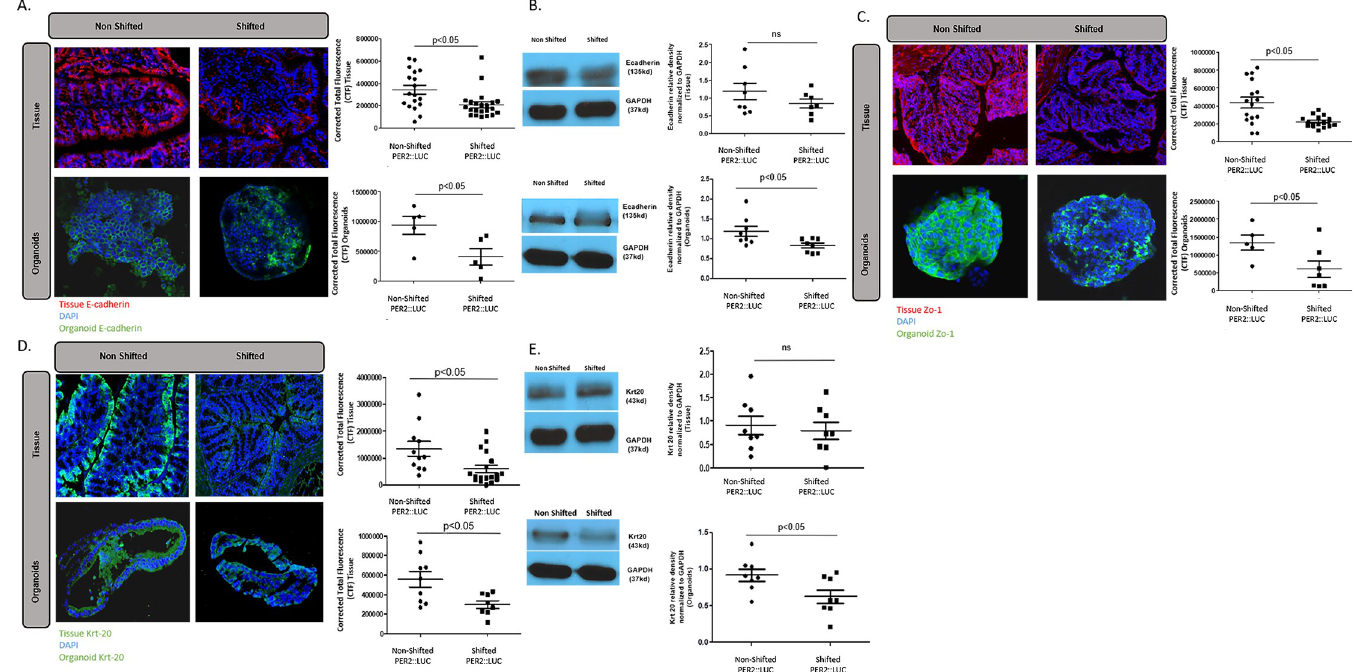
Fig 4. Colon tissue and organoid AJC protein expression is decreased with LD shifting in Per2::Luc mice. (A) Immunofluorescent staining of E-cadherin (red) in the colon tissue and organoids of shifted and non-shifted Per2::Luc mice. Both demonstrated a significant decrease in E-cadherin in the shifted mice (p < 0.05). (B) Western blot protein quantification demonstrated a similar trend in E cadherin levels. While the difference was non-significant in the tissue, the protein levels of E-cadherin were significantly lower in the colon organoids of the shifted Per2::Luc mice. (C) Immunofluorescent staining of ZO-1 (green) in the colon tissue and organoids of the shifted and non-shifted Per2::LUC mice. In both organoids and tissue, the shifted mice again demonstrated a lower amount of tight junction ZO-1 in the colons of the shifted mice (p < 0.05). (D) Immunofluorescent staining of cytoskeleton protein Krt-20 (green) in the colon tissue and organoids of shifted and non-shifted Per2::Luc mice. Both tissue and the organoids demonstrated a significant decrease in Krt-20 after shifting (p = 0.0086, 0.020). (E) Western blot protein quantification of Krt-20 levels in colon tissue and organoids of shifted and non-shifted Per2::Luc mice. No difference was seen between the non-shifted and shifted colon tissue levels of Krt-20, however, a lower amount was seen in the colon organoids of the shifted mice compared to those of the non-shifted mice (p < 0.05). This could be due to the same dilution effect seen in section B. Per2:Luc mice colon tissue and organoids. Western blot data for ZO-1 protein was too variable